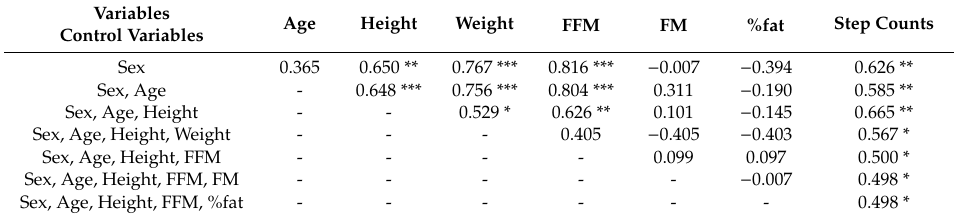
Figure 1. Simple correlation between total daily energy expenditure (TDEE) and fat free mass ( A ), body weight ( B ), or daily step counts ( C ). Relationship between physical activity level (PAL) and daily step counts is also shown in panel ( D ). Table 3. Partial correlation coefficients between TDEE (kcal/day) and other variables.